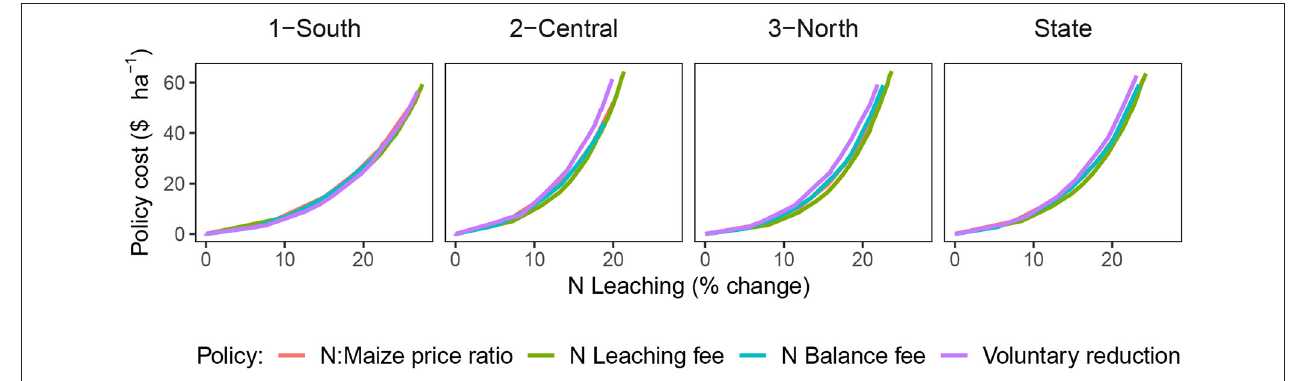
FIGURE 3 | Efficiency of Policies for Reducing N-NO 3 leaching relative to the base-level situation. Solid line shows the mean across all fields and years.